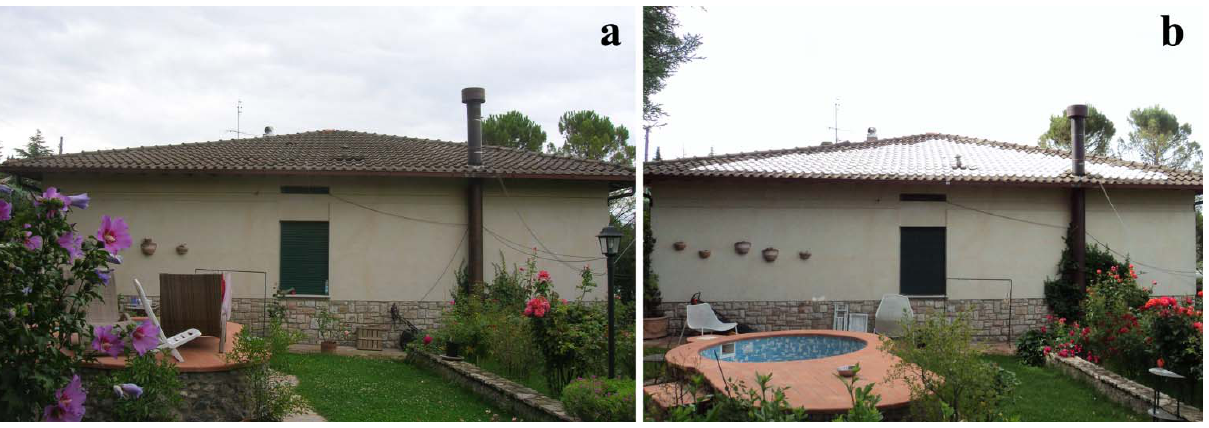
Figure 2. ( a ) Scenario 0 with original tiles compared to Scenario 1 configuration; ( b ) with reflective